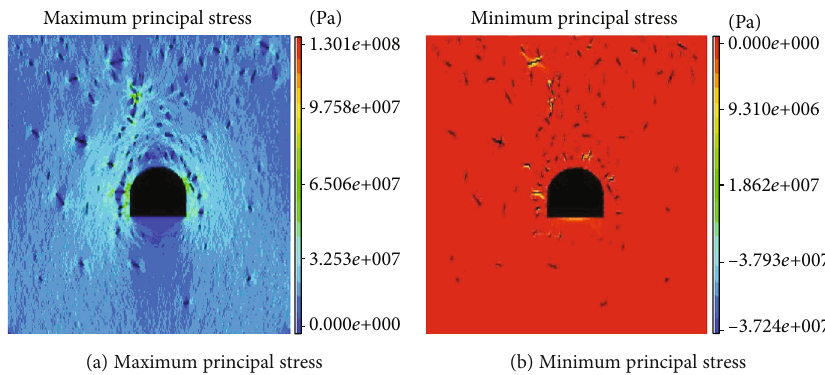
Figure 8: Stress distribution of roadway surrounding rock after excavation.